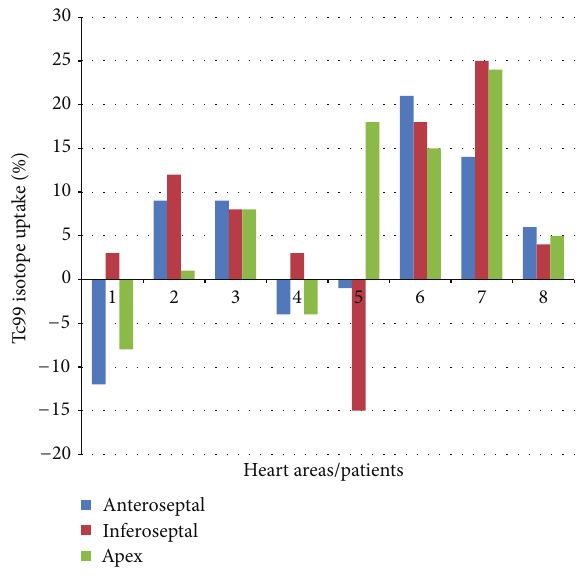
Figure 3: Tc99 isotope uptake in different areas of the heart I poststress condition, quantitative measurements of activity in the area at risk (anteroseptal, inferoseptal, and apex) expressed as the difference between postoperative perfusion and preoperative